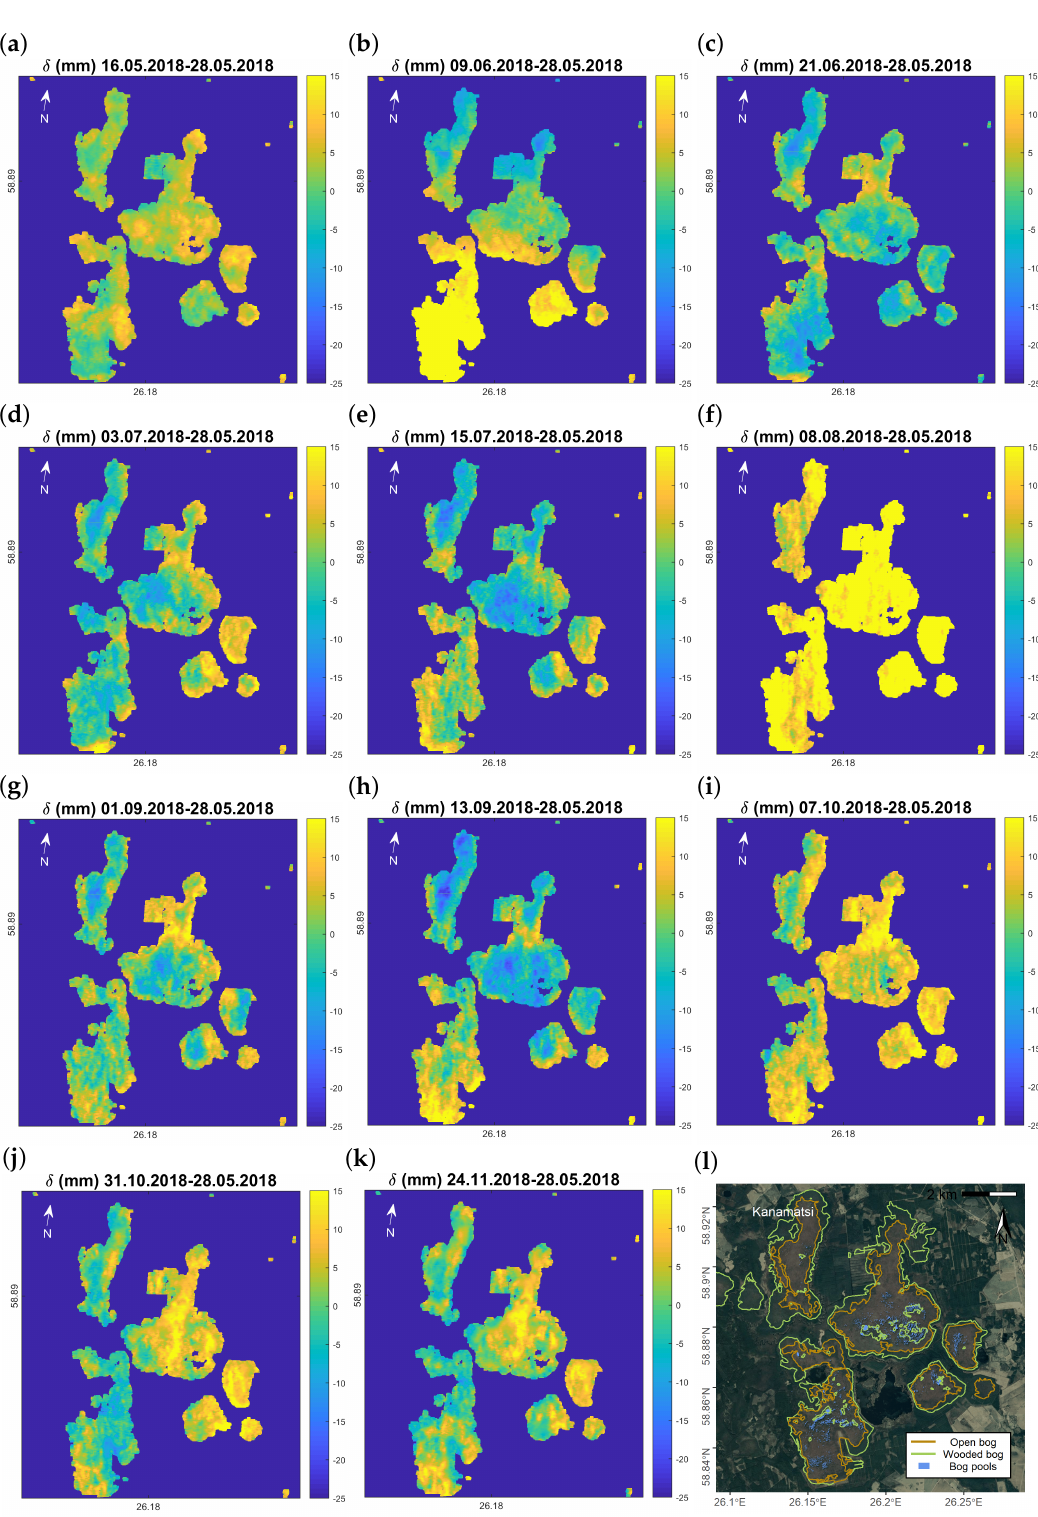
Figure 8. DInSAR displacement (mm) maps for open bogs in Endla mire complex from 16 May 2018 to 24 November 2018 ( a – k ), derived relatively to a single master image (28 May 2018), and an optical satellite image of the area ( l ) in relation to land cover types. All displacement images ( a – k ) are leveled to a single height point selected from Kanamatsi bog (area in upper left corner of the